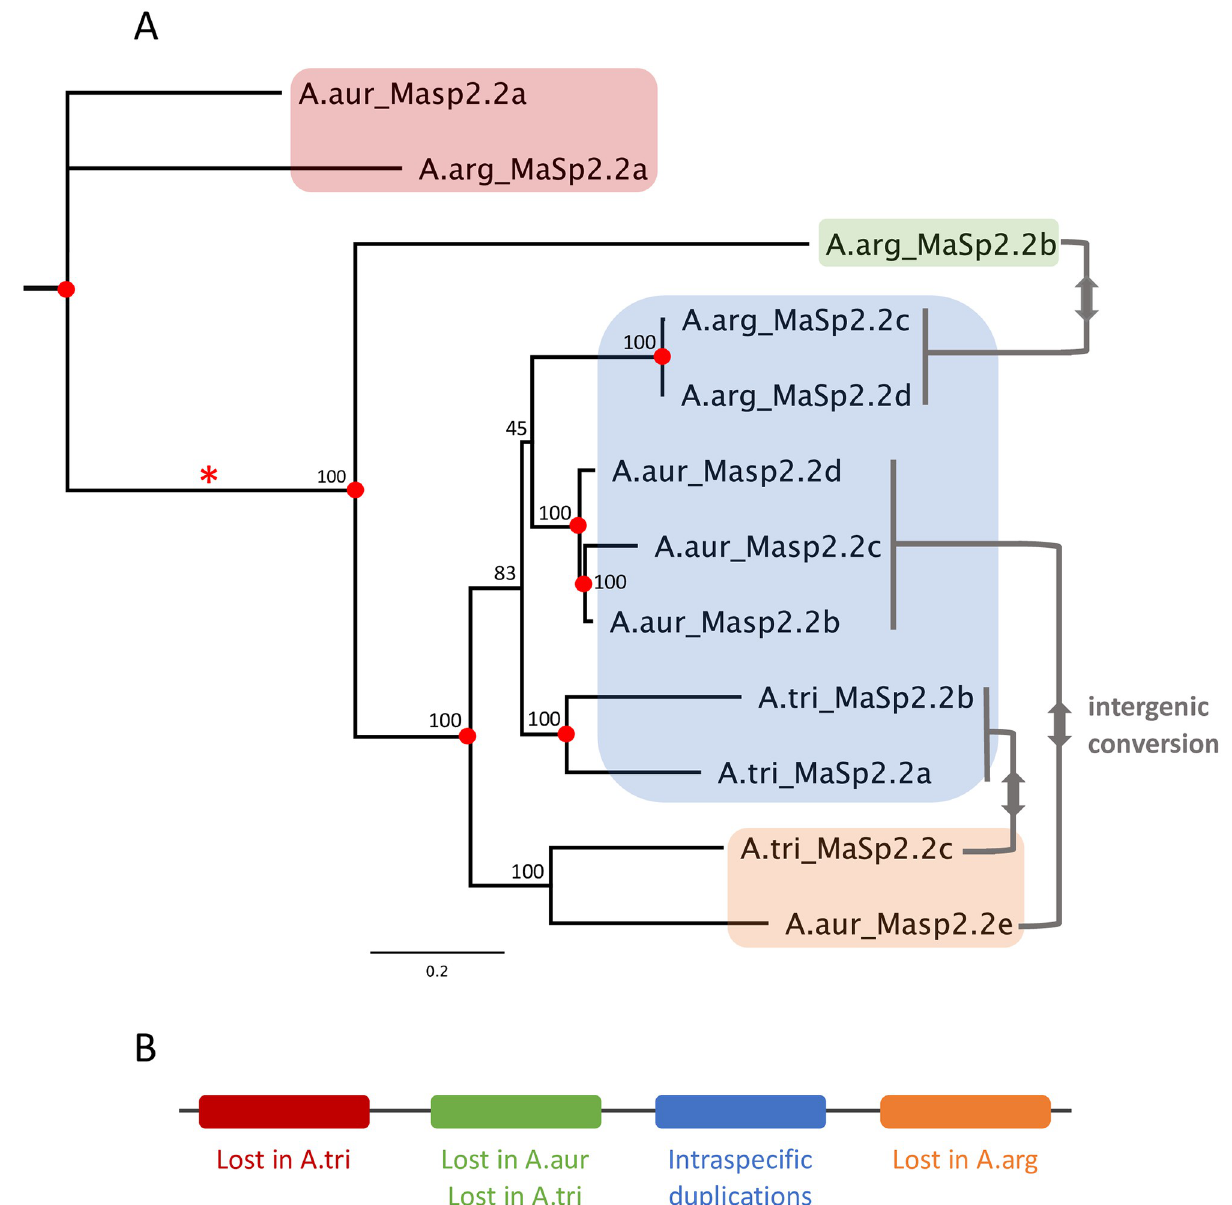
Fig 5. Gene gain/loss and intergenic conversion for Argiope MaSp2.2 genes. A) Phylogenetic relationships among MaSp2.2 genes based on flanking sequence. Approximately 1000 bp of sequence data directly upstream and downstream of the protein-coding sequence for each gene were concatenated and aligned to produce this topology. Nodes provide bootstrap support and duplication events (red circles). Asterisk indicates node discussed in Results. Putative intergenic gene conversion events for repetitive regions (gray bars) are summarized (see text for details). B) Putative ancestral gene organization for original genes from the four primary clades and gene gains or losses summarized for each taxon in each clade.